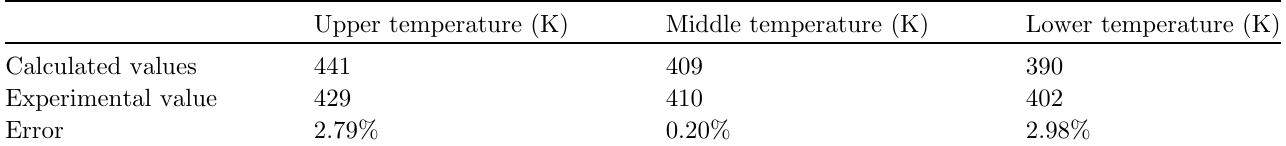
Table 3. Comparison of experimental values.